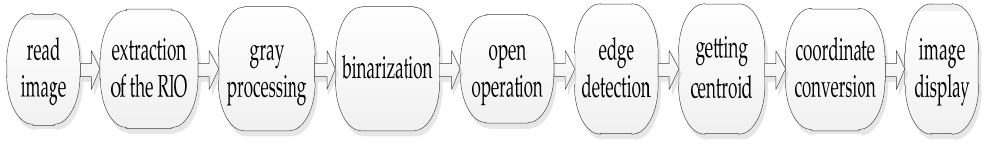
Figure 8. The flowchart of the image processing.